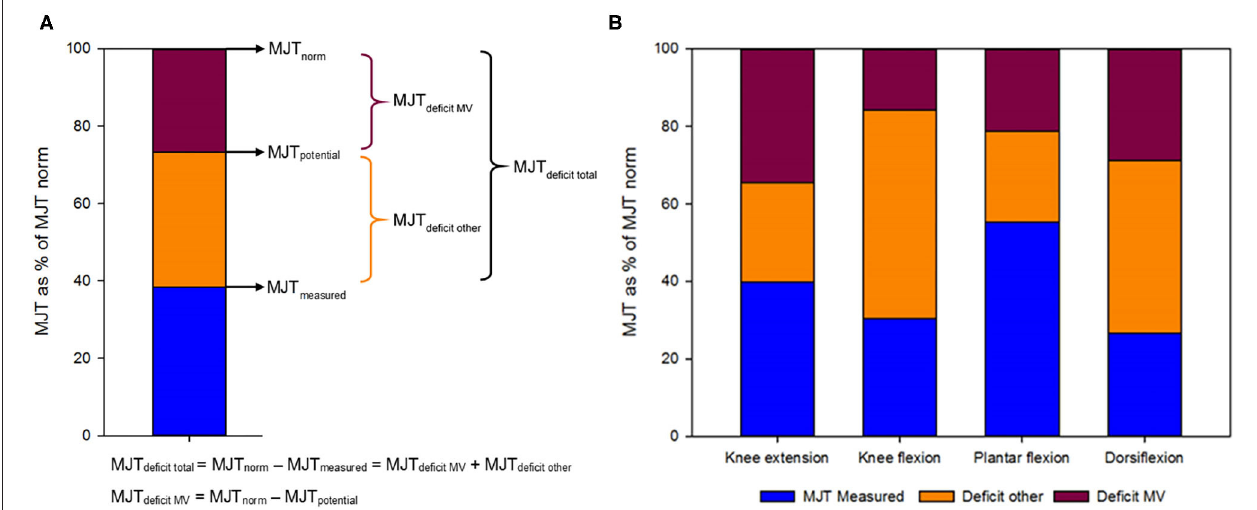
FIGURE 2 | (A) Fictive example of the calculation of the different maximal joint torques (MJT) that were measured or estimated as a percentage of the expected score in typically developing children, their relative representation and their corresponding deficits. MJT potential was based on muscle volume and the relationship with MJT in the typically developing cohort. The MJT norm was based on the relationship of MJT with height in the typically developing cohort. The blue part indicates the relative MJT measured . The red part indicates the relative MJT deficitMV , i.e., the deficit in strength that is proportional to the deficit in muscle volume. The orange part of the graph indicates the relative MJT deficitother , representing the deficit in MJT that comes from other factors than the decrease in muscle volume. (B) Representation of the measured MJT and deficits relative to the expected score in typically developing children for four lower limb joint movements.